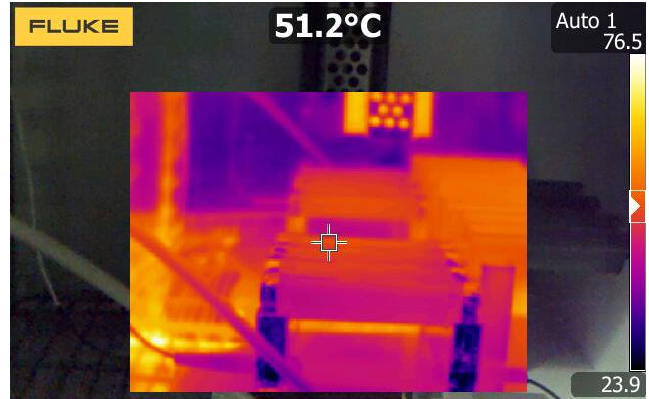
Figure 3. Samples placed in the heating chamber.